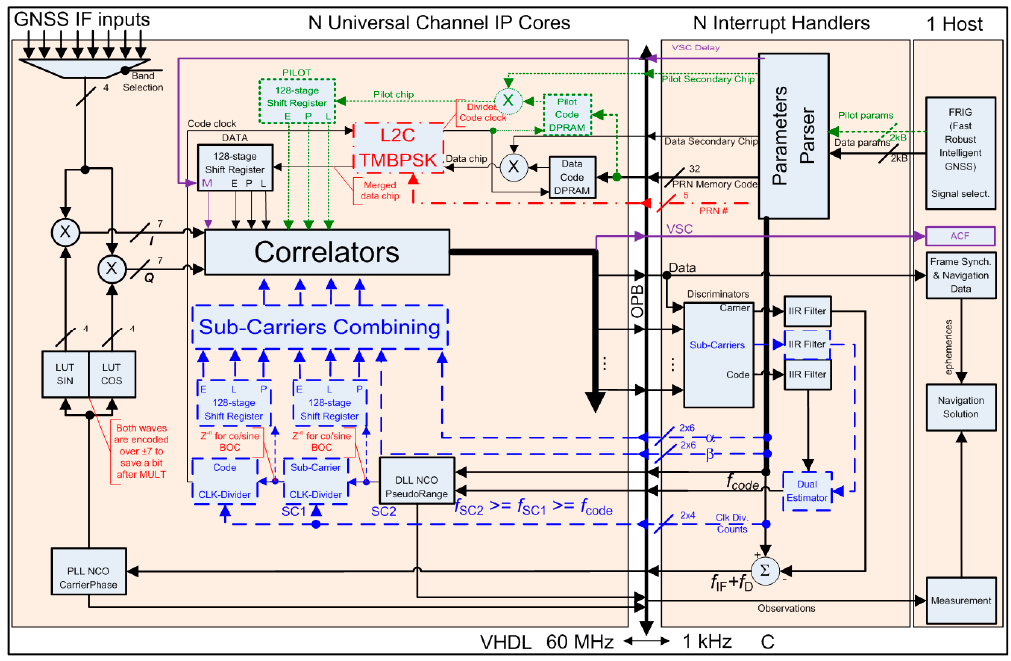
Figure 9. Proposed Universal Channel High Level Architecture.